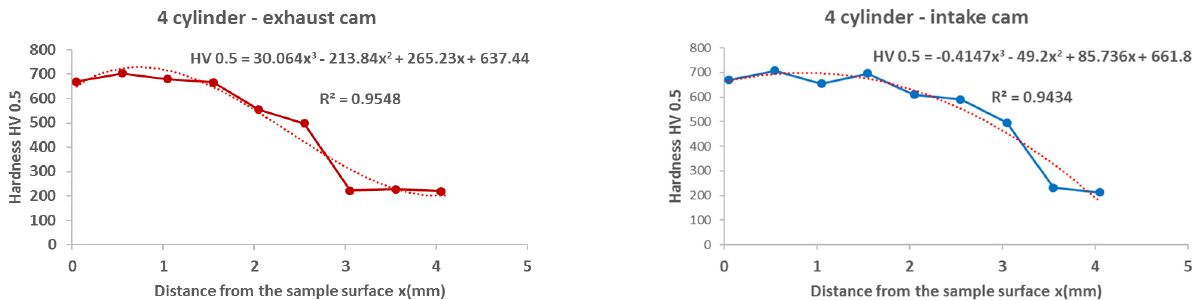
Figure 16. Regression analysis for a 3rd − order polynomial for the values of the 4th cylinder on the exhaust and intake cams.